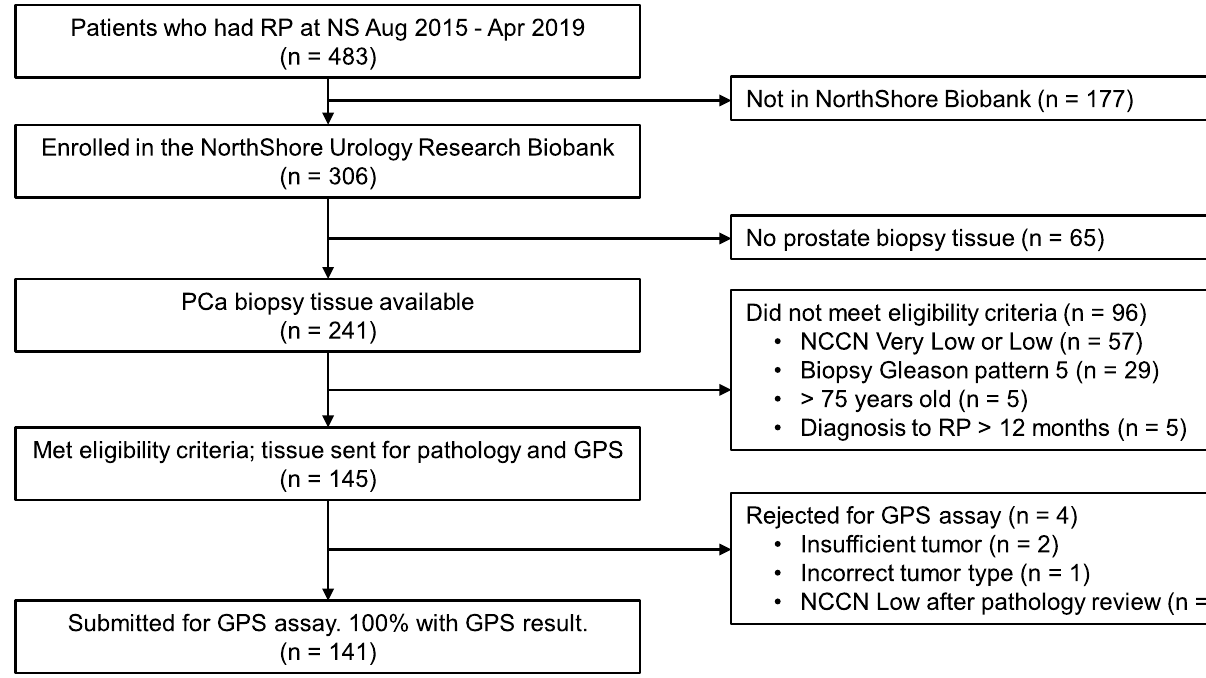
Fig 1. Flow diagram. Flow diagram showing included (n = 141) and excluded (n = 342) patients.